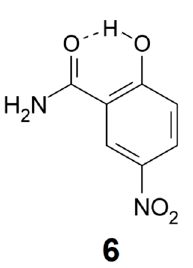
Figure 1. The OH stretching region of the IR spectrum of acetylacetone. Top: Observed spectrum. Bottom: Simulated OH stretching band of the intramolecularly hydrogen-bonded enol form ( 3 ) of acetylacetone, adapted with permission from Mavri and Grdadolnik [63] (copyright © 2001, American Chemical Society). The observed spectrum contains contributions from the diketoform of acetylacetone, and from CH-stretching bands and summation bands, contributions which are not included in the theoretical simulation.